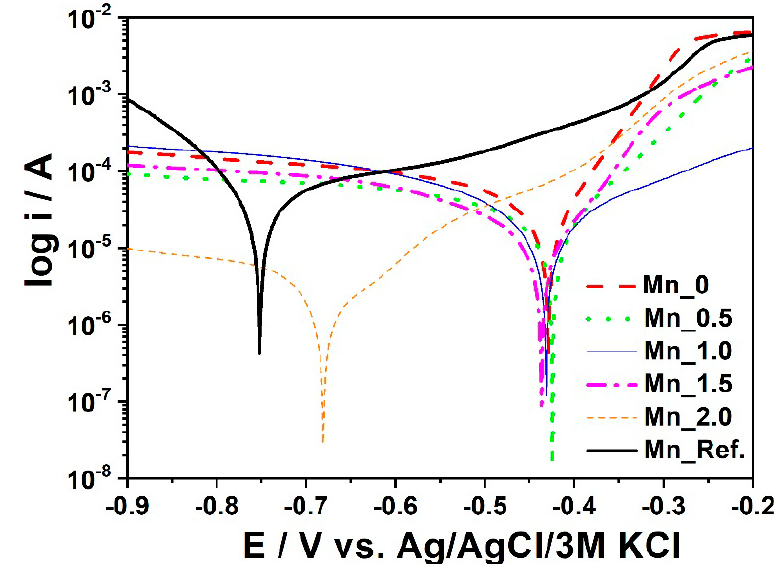
Table 8. The values of corrosion potential, current density, and corrosion rate estimated for the samples with Mn content. Figure 10. Polarization curves registered for samples with different Mn Figure 10. Polarization curves registered for samples with different Mn contents.